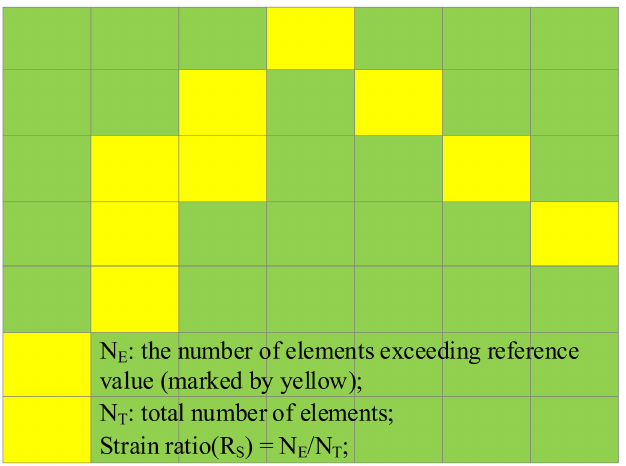
Figure 12. Sketch map of strain ratio. Based on the same theory, the strain values of each element under different frames can be obtained through the simulation result file, by which the number of elements exceeding the reference strain was obtained. Then we got the strain ratio of simulation. The strain ratio curves of the experiment and simulation under different strain refer- ence values are compared (Figure 13). The solid line is the experimental strain ratio curve corresponding to the left side longitudinal axis. The dashed line is the simulated strain ratio curve, and the corresponding longitudinal axis is the right axis. The transverse axis of the curves is strain.